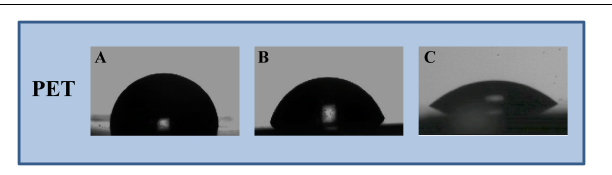
FIGURE 1 | Water contact angle measurements performed on (A) pristine PET, (B) oxygen plasma activated-PET, and (C) MTP1-functionalized PET. The measurements were performed on five samples in